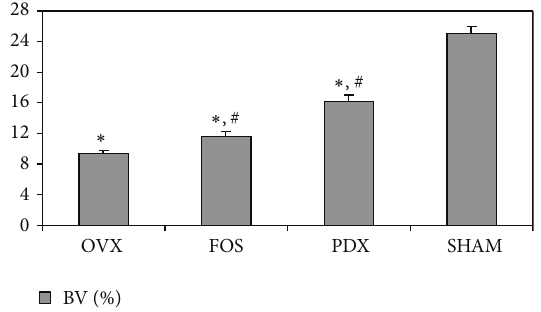
Figure 2: Femoral bone volume percentage (BV%) at the end of the study. ∗ 𝑃 < 0.01 versus SHAM; # 𝑃 < 0.05 versus OVX. Differences were analyzed by Bonferroni test after